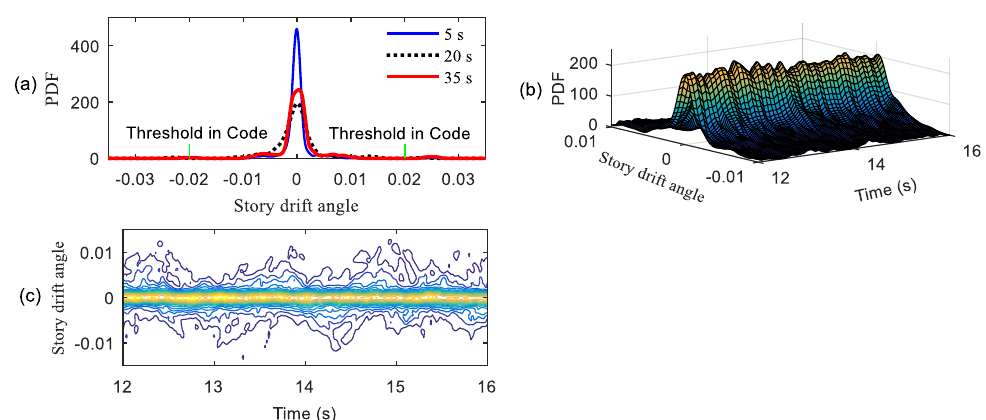
Figure 17. Story drift angles of the third story excited by stochastic simulated seismic ground motions of site IV group 3 (rare earthquake): ( a ) probability distribution at certain time instants; ( b ) PDF evolution surface; ( c ) contour of the PDF surface.